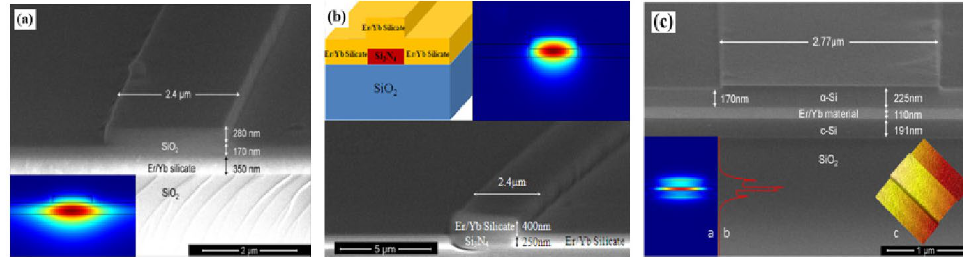
Figure 4. Scanning electron microscope (SEM) of ( a ) strip loaded waveguide amplifier, ( b ) hybrid waveguide amplifier, ( c ) slot waveguide amplifier [42].